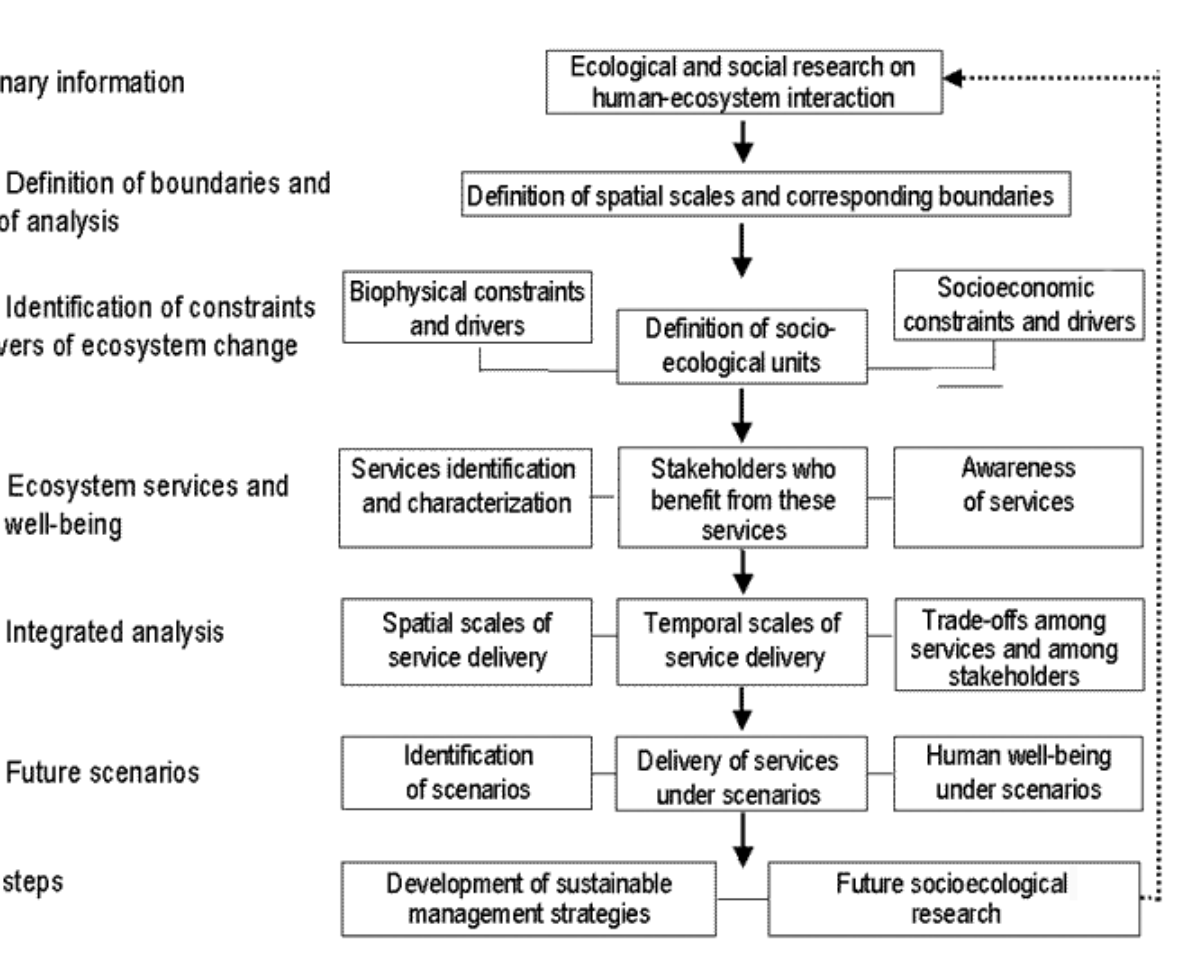
Fig. 1. Methodological approach used in the analysis of the services delivered by a tropical dry forest region of western